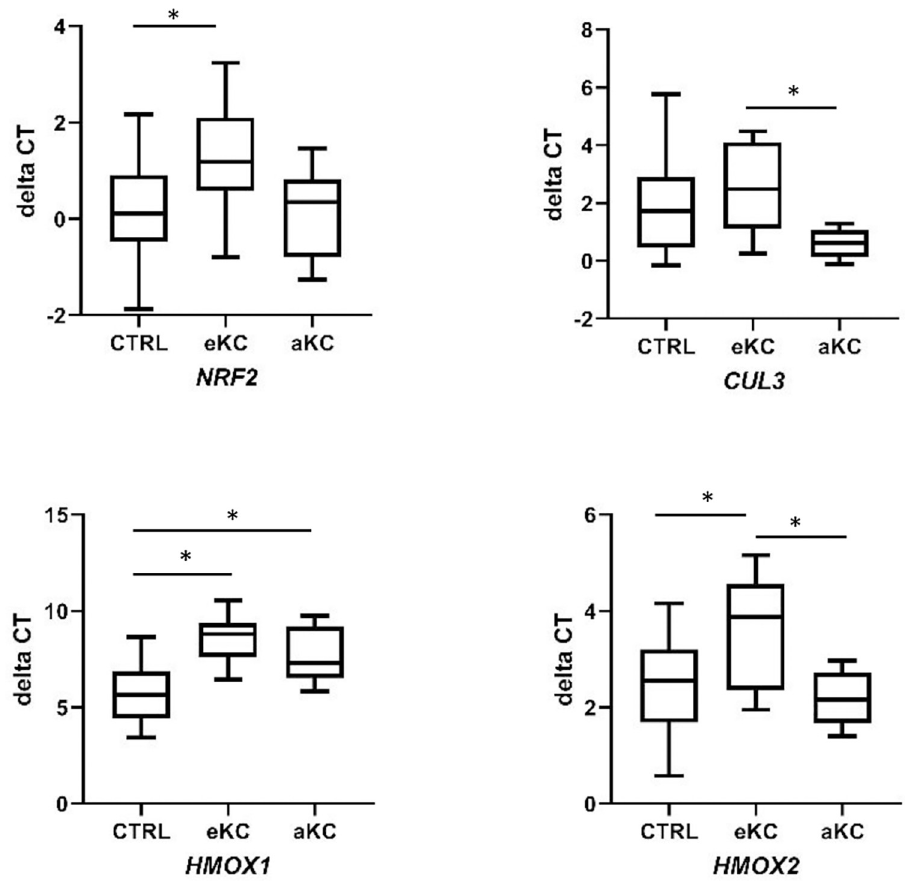
Fig 3. Comparative expression of NRF2 pathway genes in early and advanced keratoconus. Box and whiskers plots of gene expression in the corneal epithelium of control (CTRL; n = 20), early keratoconus (eKC; n = 11) and advanced keratoconus (aKC; n = 6). Transcript level expressed as mean of delta cycle threshold (dCT) normalized to housekeeping genes. Non-parametric Kruskal-Wallis test. P < 0.05 was considered as statistically significant. � , P value < 0.05.